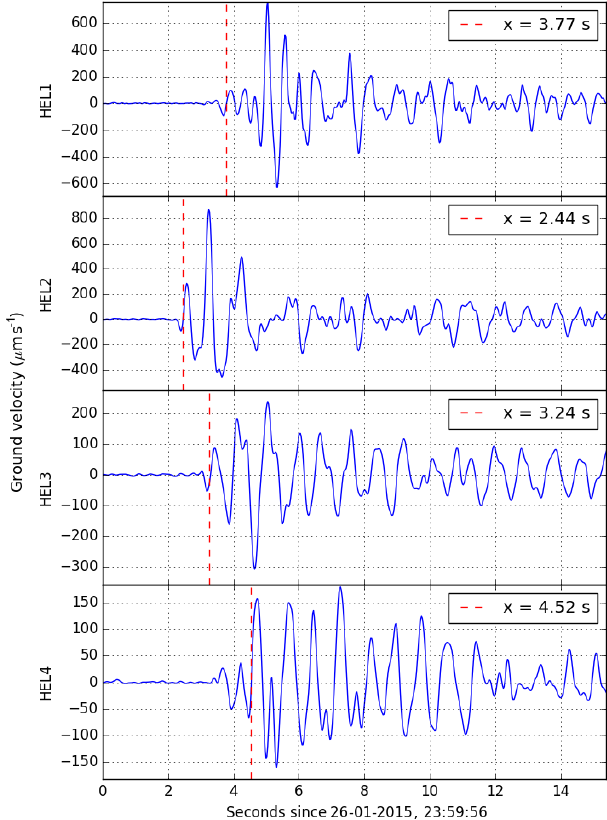
Figure 4. Seismic signals for a calving event at Helheim Glacier on 26 January 2015. The signal onset times are determined using an automated script that searches for the first instance of a gradient exceeding a particular threshold as defined in Sect. 3.2. The differ- ences in the wave onset times are then used to generate a character- istic path difference for each